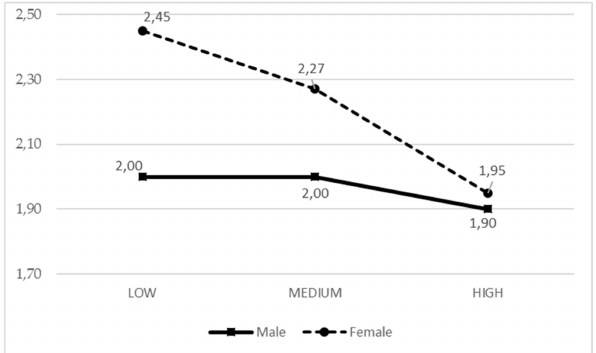
Figure 1. Means of the IPAF1 parental style based on the adolescent gender for boredom.